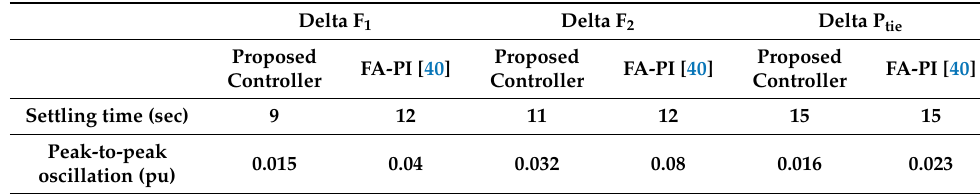
Table 5. Dynamic performance indices of case 1.